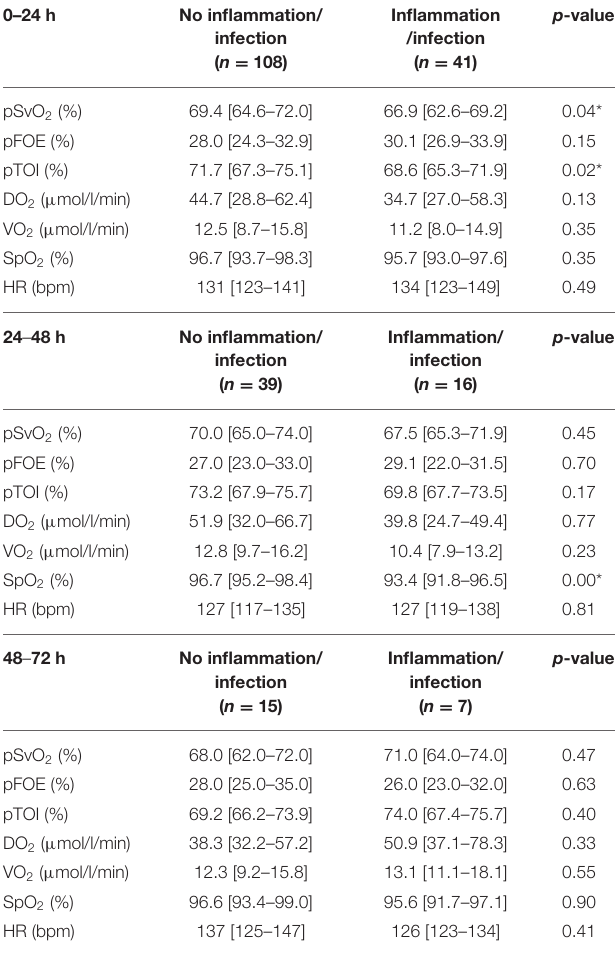
TABLE 2 | Outcome parameters presented as median and interquartile range [25 th and 75 th percentile] compared between healthy preterm neonates and those with early inflammation/infection during the first 72h after